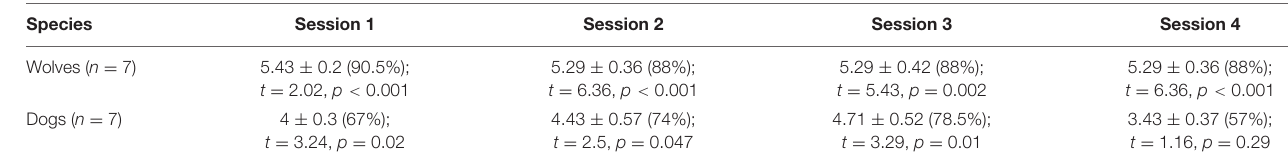
TABLE 4 | Wolves’ and dogs’ performance in attention trials.